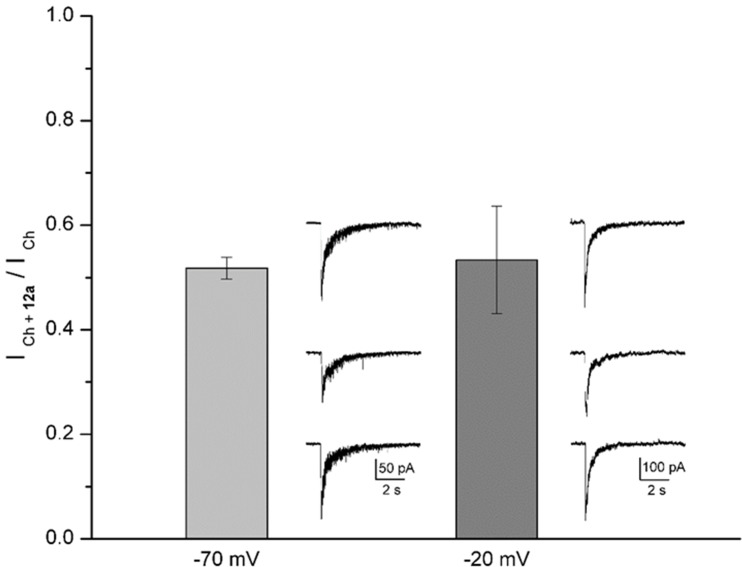
Voltage independence of 12a effects. The height of the columns represents the ratio between the ICh in the presence of 5 μM 12a (ICh
+
12a) and the control ICh at the holding potential indicated. A representative control, inhibited, and recovered ICh (upper, middle, and bottom traces, respectively) recorded from the same interneuron are illustrated at the right of the corresponding column. Different cells were recorded for each holding potential. Each column represents the mean ± standard error with no statistical difference (n = 5 interneurons).